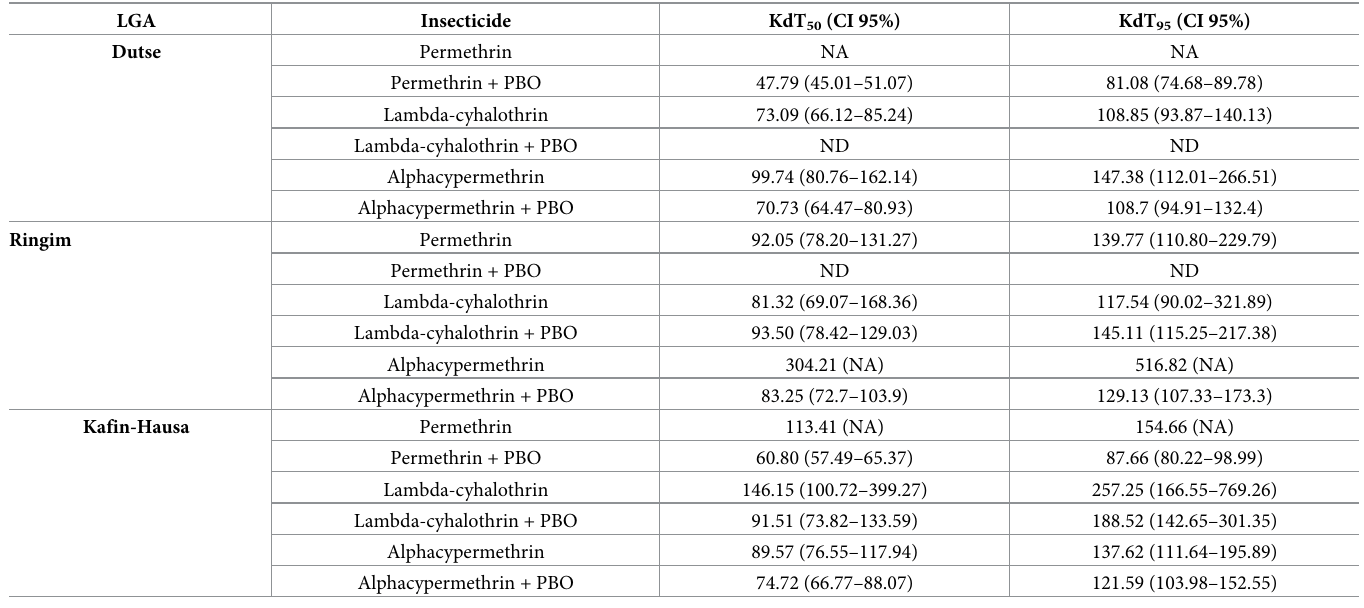
Table 2. KdT 50 and KdT 95 values of Cx . quinquefasciatus populations from Jigawa, North-West Nigeria exposed to Pyrethroids.